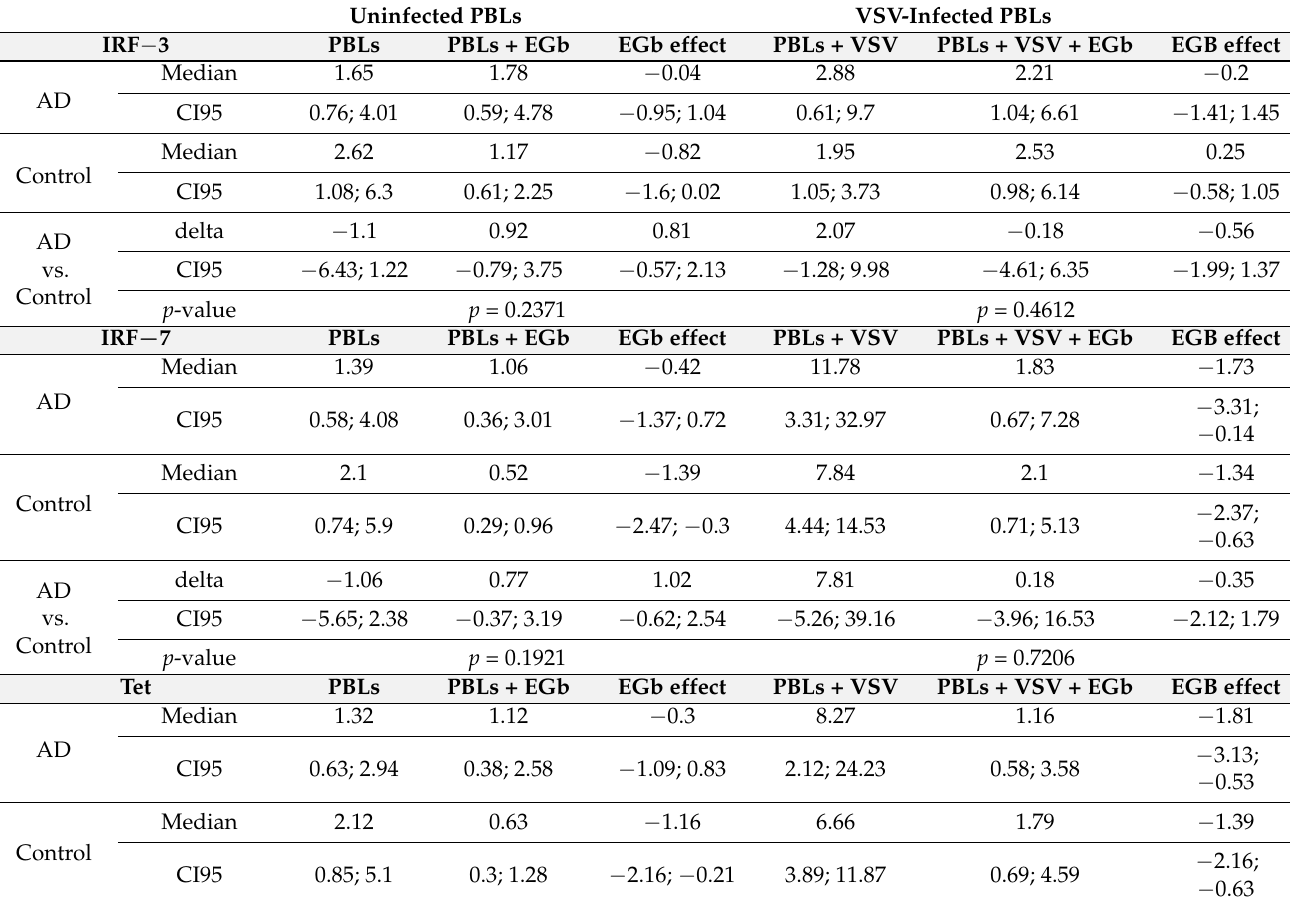
Table 6. Genes expression before and after EGb treatment and measure of EGb effect in AD patients and control group. Median is measure of average level. For every individual person and for every gene change of expression level after, treatment equals d = log after EGb effect is average of all d s in a group. EGb effect is the average of ratios after Delta ∆ is measure of difference in EGb effects between AD and controls, and this statistic is the average difference between a randomly selected person from AD group and a randomly selected person from control group.